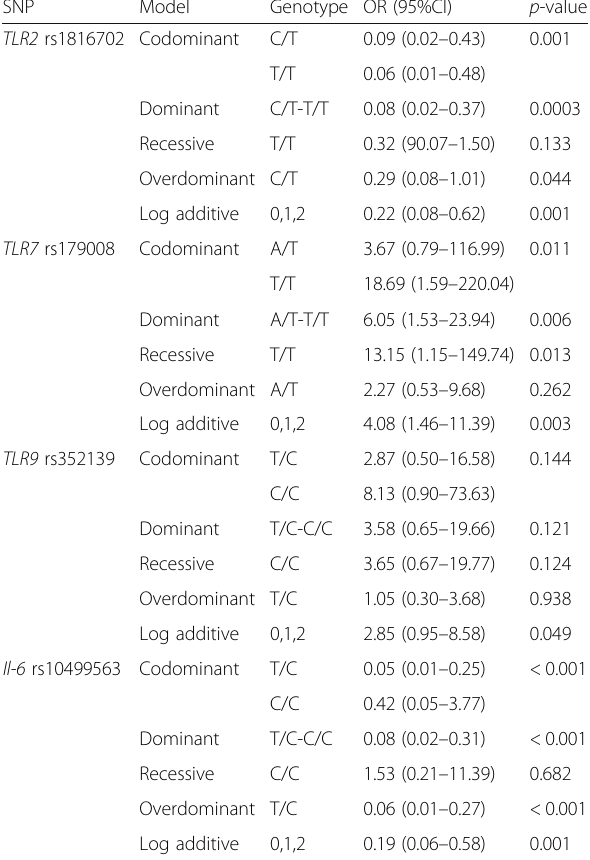
Table 3 Multivariable adjusted models containing BMI and significant SNPs in univariable analysis for CMV